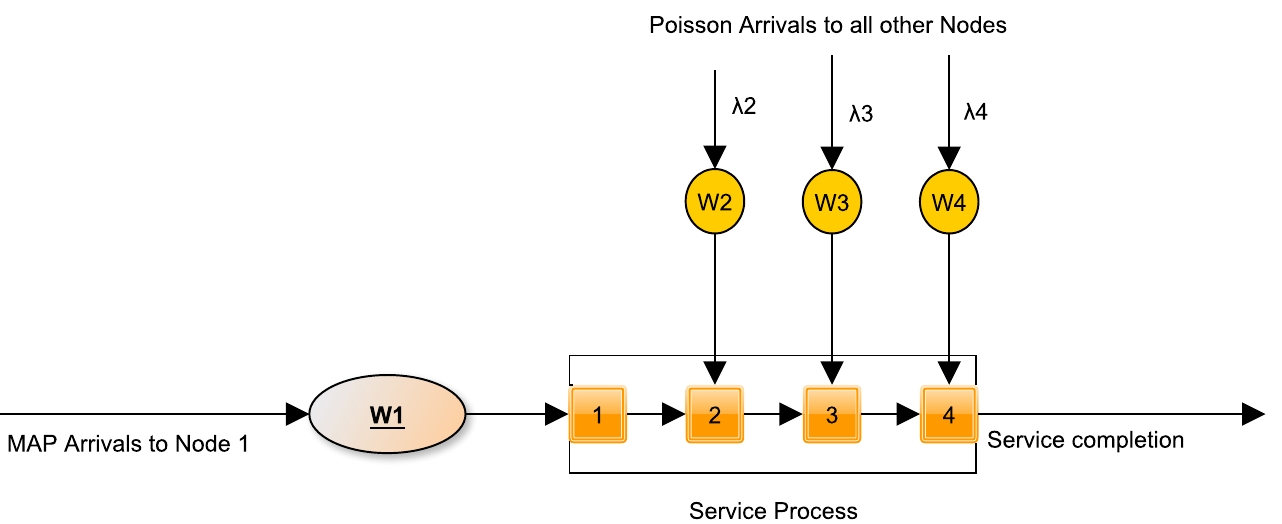
Figure 1. Queueing system with four stages of service, with accessibility to service from the beginning of any